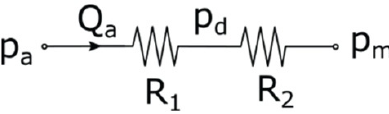
Figure 2. In the unidimensional model, the stenosis and the arterioles are represented by two resistors (R 1 and R 2 ) connected in series.